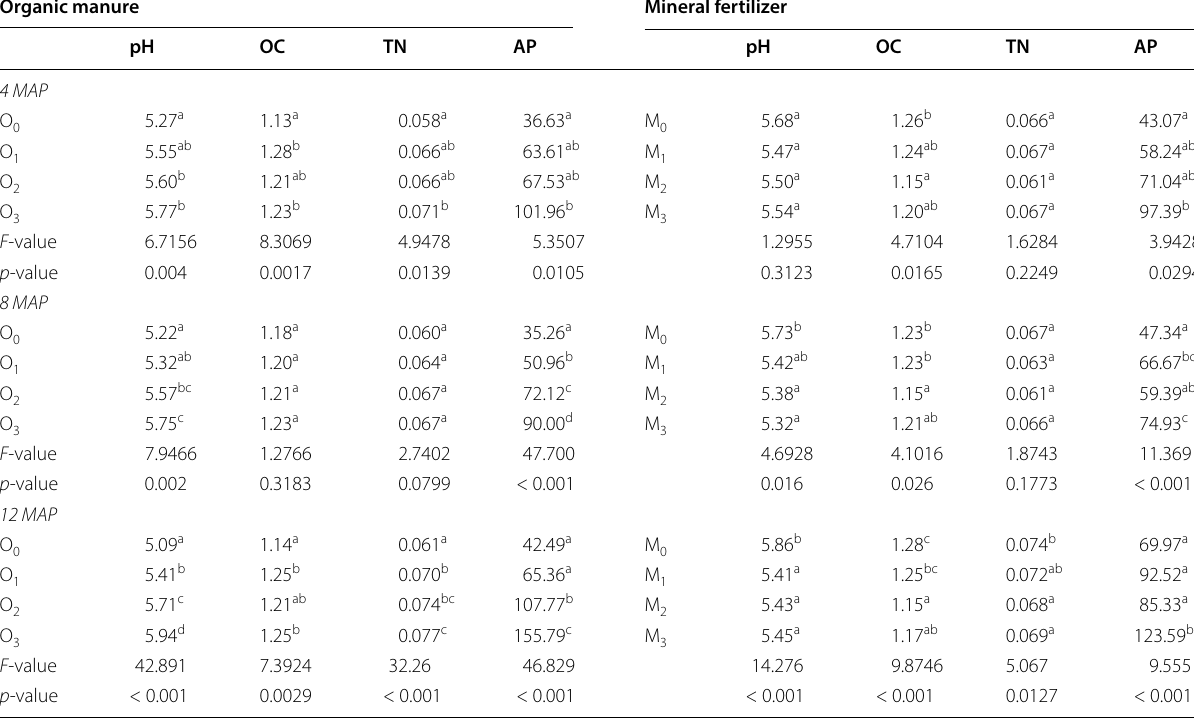
Table 2 Cassava fertilization effect on pH (water), OC (%), TN (%) and AP (mg kg − 1 ) over the three different sampling periods after planting at α 0.05 =